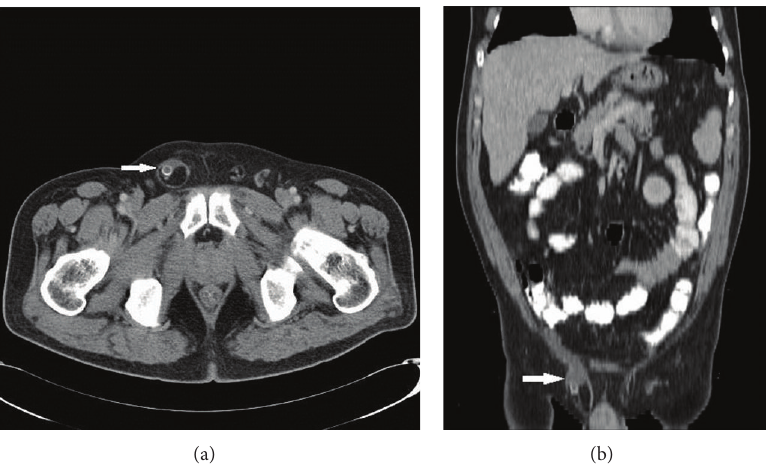
Figure 1: Amyand’s hernia was showed after intravenous (IV) contrast CT of the abdomen. Axial (a) and coronal MPR (b) images. A small amount of fluid around appendix with appendiceal fecalith is seen on the axial image (arrow). The inflamed appendix is particularly well, as seen on the coronal reformats